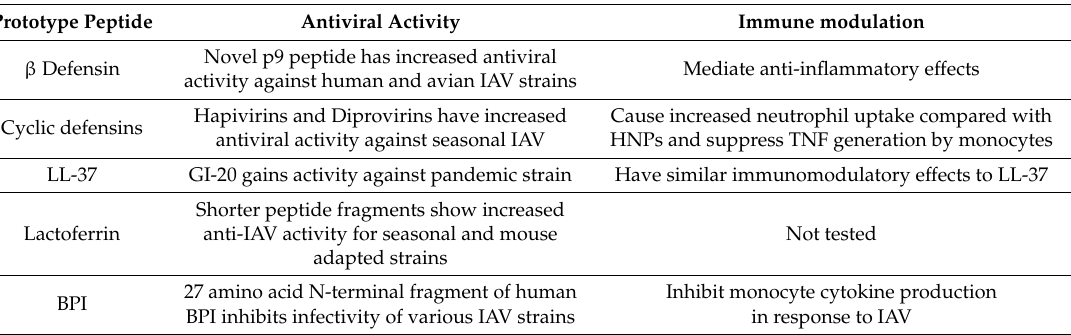
Table 2. Therapeutic Directions: Creation of Novel